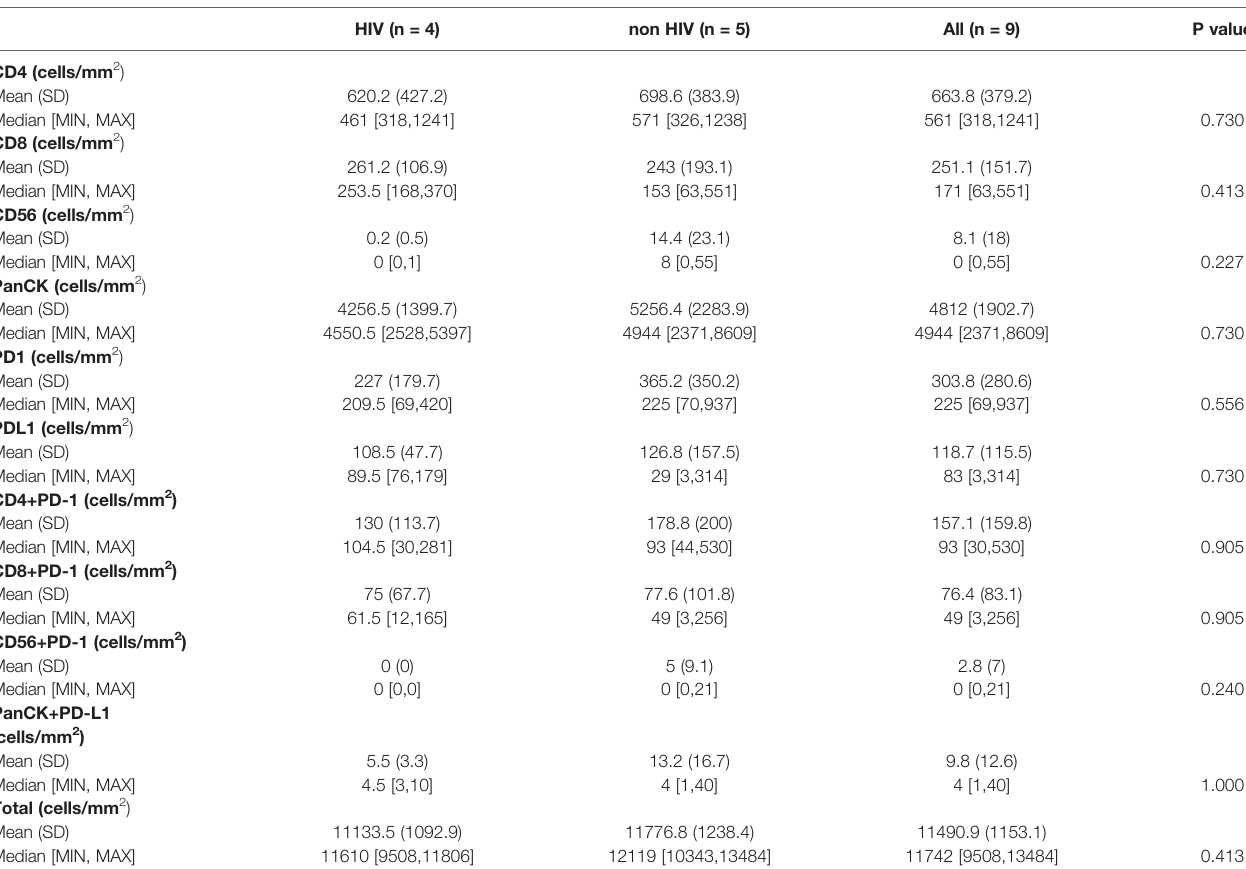
TABLE 2 | Summary of Cell Density